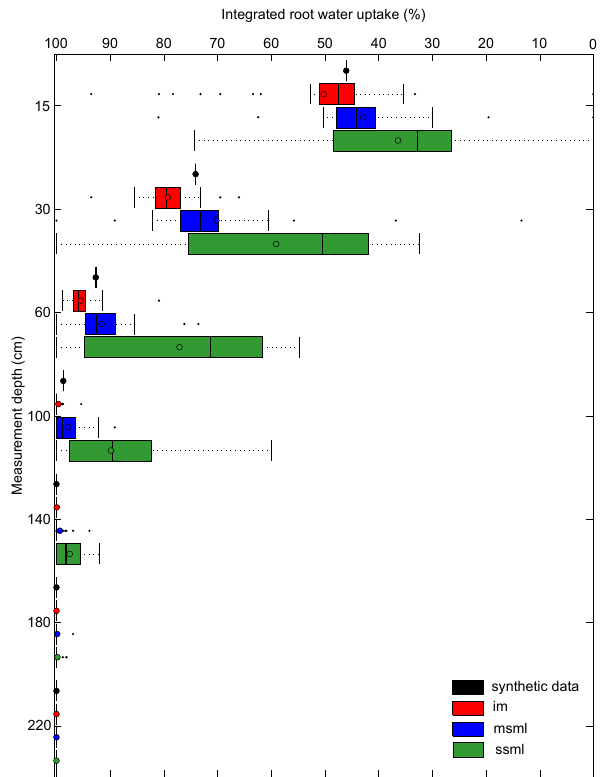
Figure 4. Box plots of the estimated daily percentage of integrated sink term. Colors are assigned as follows: synthetic values are black, the im is red, the msml regression is blue and the ssml water bal- ance is green. The percentage of integrated sink term is shown for all measurement locations over the soil column. The circles show the mean values; the vertical line depicts the median and the 25 and 75% percentile. Values are given for the respective underlying time resolution which achieved the best results according to Table 3 (ssml – 1h; msml – 1h; im –